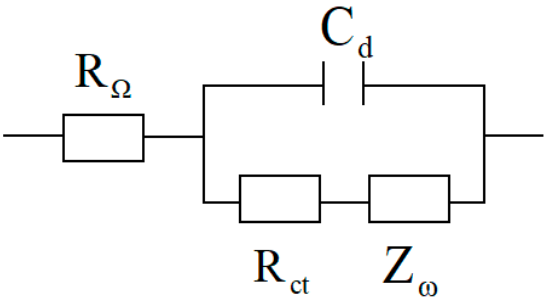
Figure 7. In a 0.1 mol/L Na 2 SO 4 (PH (Hydrogen ion concentration index) =7) solution, keeping the bias voltage at 1.5 V, using a standard calomel electrode as the reference electrode to test the J-T image of the sample.